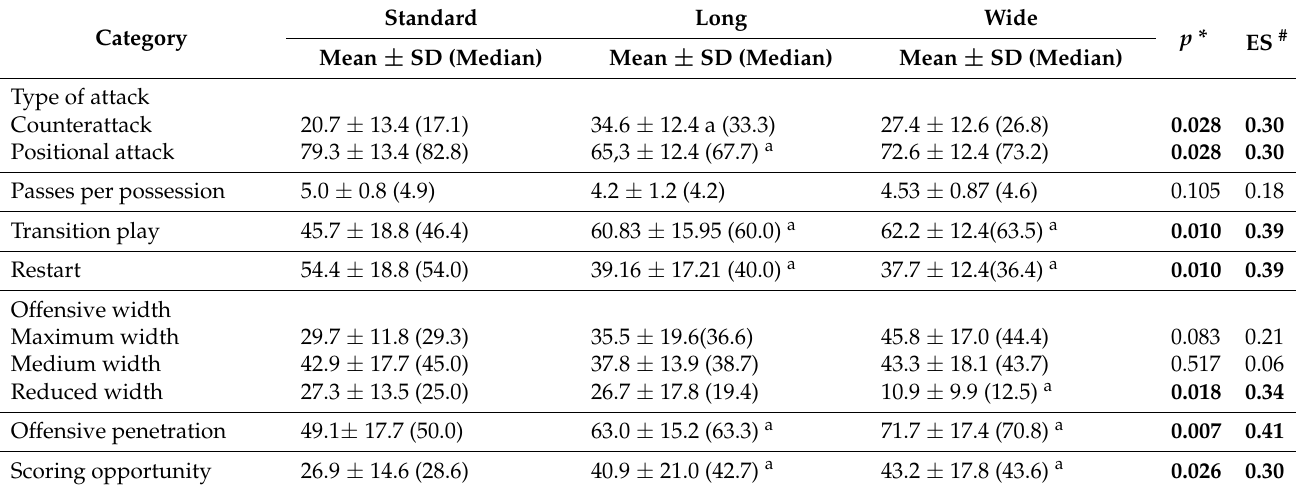
Table 4. Comparison of playing tactics between the three different pitch